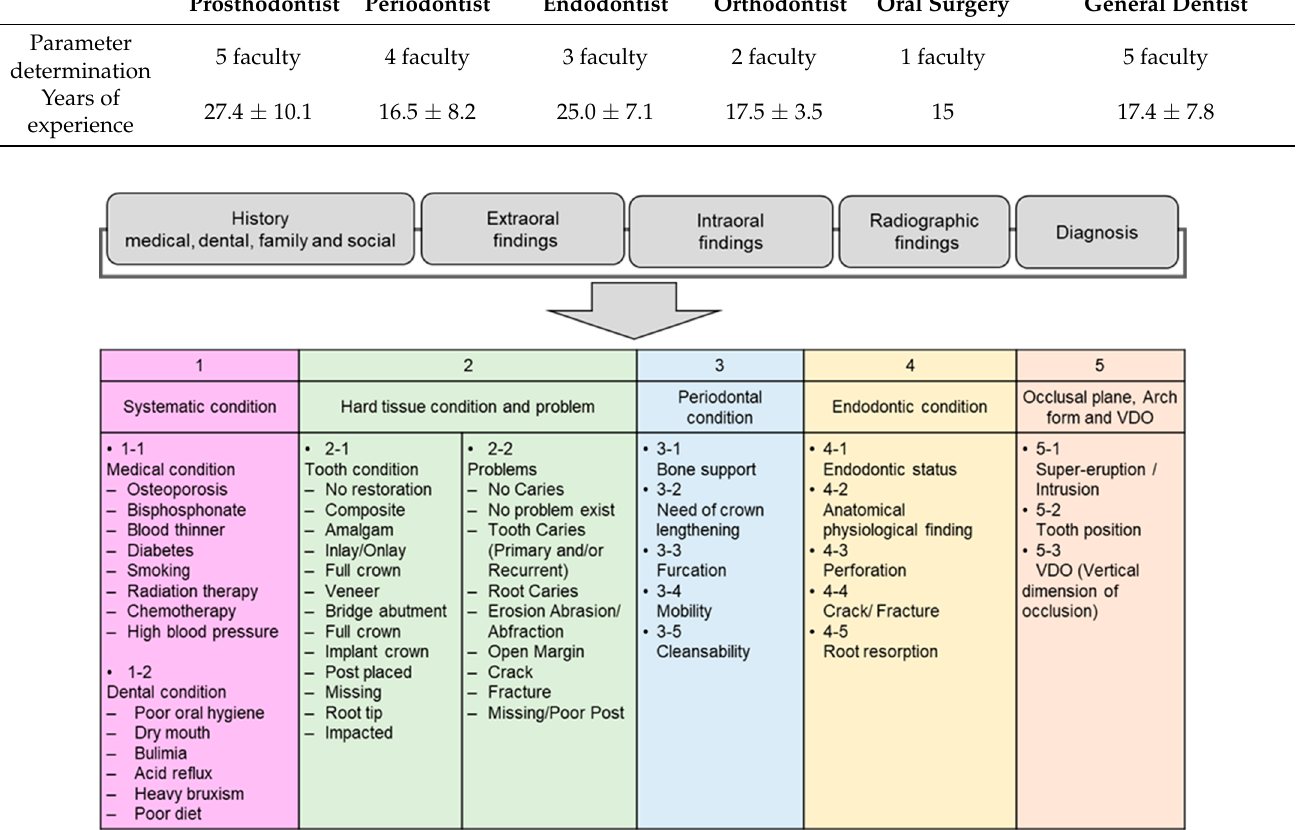
Figure 1. Seventeen key parameters used for determination of tooth prognosis.